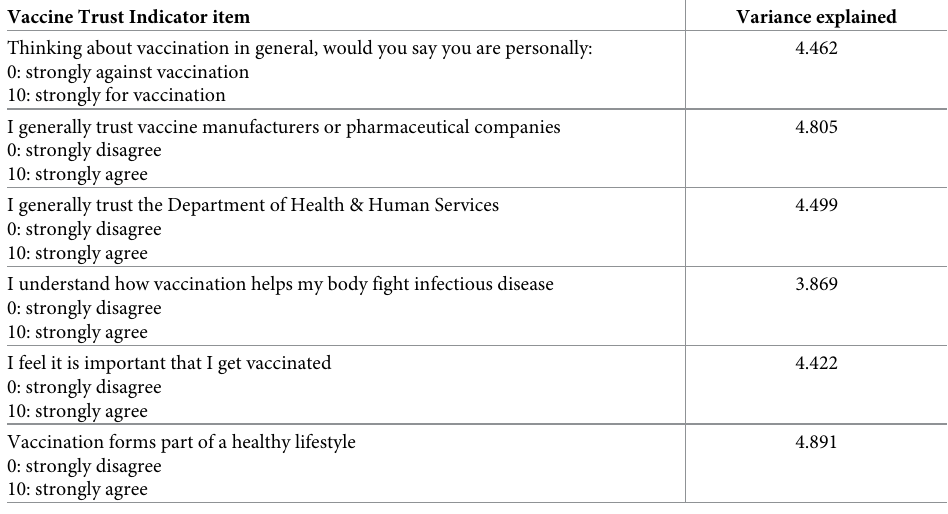
Table 5. Variance of dependent variable explained by Vaccine Trust Indicator